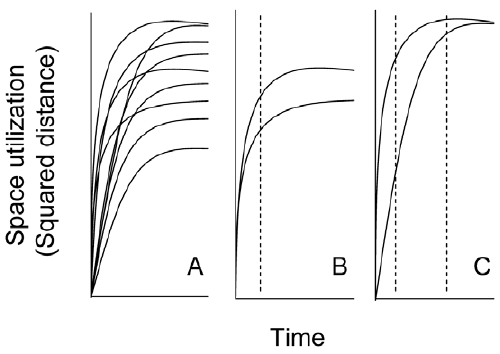
Figure 1. Schematic daily squared displacement over time of a fish moving with a home range (HR). Schematic representation derived from empirical observations using acoustic telemetry tech- niques in the marine small-bodied fishes Serranus scriba , Serranus cabrilla and Xyrichthys novacula [37,38,43]. In all cases, the squared distances reached an asymptote as a characteristic of the general mechanism of the HR behaviour [42]. Two general patterns can be derived from the within-population variability observed: there were some individuals that reached an asymptote at the same time (denoted by the vertical dashed bar) but had different HR sizes (approximated by the ratio e /k , see methods section, panel B), and other individuals with the same HR size (denoted by the vertical dashed bar) but with a different way of exploring the whole HR (approximated by the parameter k , see methods section, panel C).